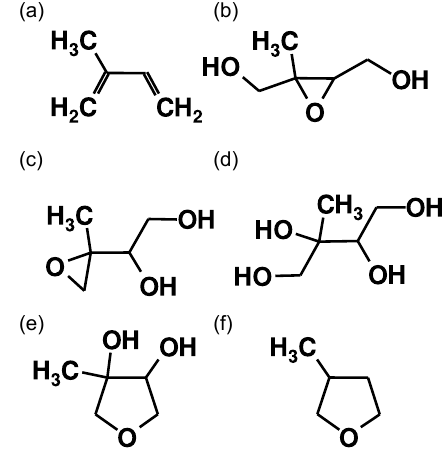
Figure 1. Organic species referred to in this paper: (a) Iso- prene, (b) β -IEPOX, (c) δ -IEPOX, (d) 2-methyltetrol, (e) 3- methyltetrahydrofuran-3,4-diol and (f)